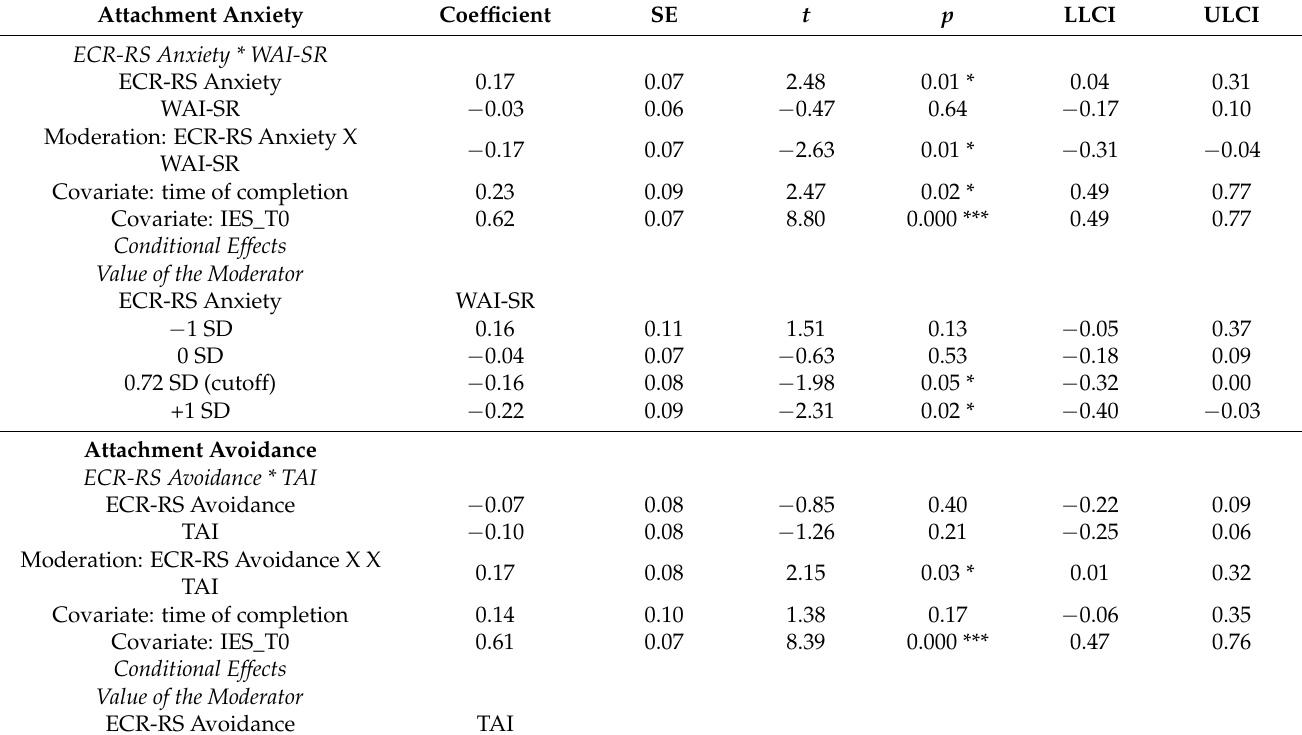
Table 4. Results and Conditional Effects of Significant Moderations of Attachment on the Relationship between the Collaborative Therapy Variables and COVID-related Traumatic Distress at Follow-up, once Controlled for baseline COVID- related Distress and Completion